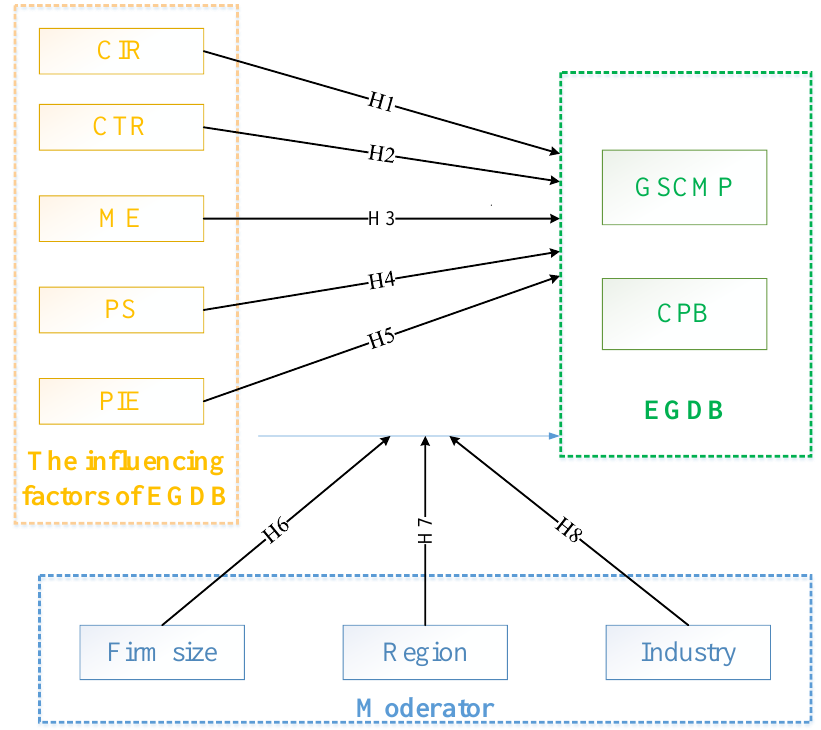
Figure 1. The research framework .